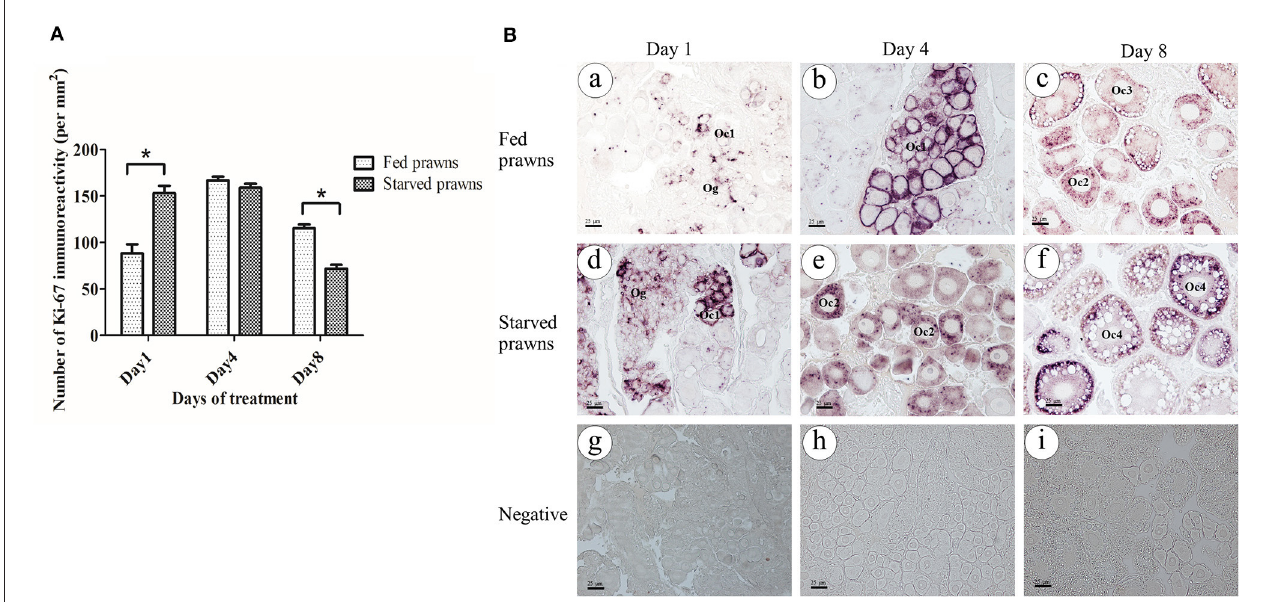
FIGURE 4 | Effect of starvation on ovarian cell proliferation. Immunoreactivity of Ki67 (number of positive cells/area) in ovaries of starved prawns significantly increased at day 1 and thereafter decreased at day 8 compared to fed prawns (A) . At day 1, the number of positively stained oogonia and Oc1 in the fed prawns’ovaries (Ba) were lower than in starved prawns (Bd) . At day 4, fed prawns’ovaries (Bb) showed immunoreactive oogonia and Oc1, whereas starved prawns’ovaries (Be) exhibited immunoreactive Oc1 and Oc2. By day 8, fed prawns’ovaries showed immunoreactive Oc3 (Bc) , whereas starved prawns’ovaries showed more intense immunoreactive Oc4 (Bf) . Negative control in all groups did not show Ki67 immunoreactivity (Bg–Bi) . Bar 25 µ m ( n = 5). Asterisks indicate significant differences compared to fed group with p <